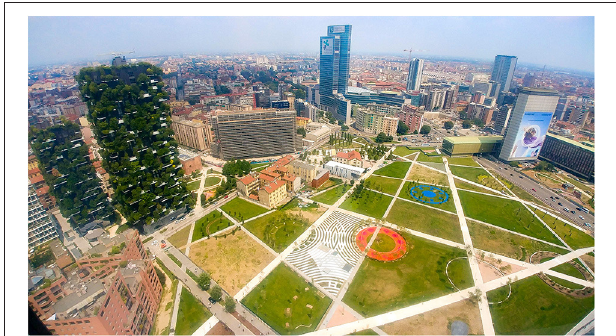
FIGURE 2 | Aerial view of BAM showing the spatial structure of the park and between the pathways, June 2018. Source: Luca Volpi, 2018; user Goldmund100 on Wikimedia (CC BY-SA